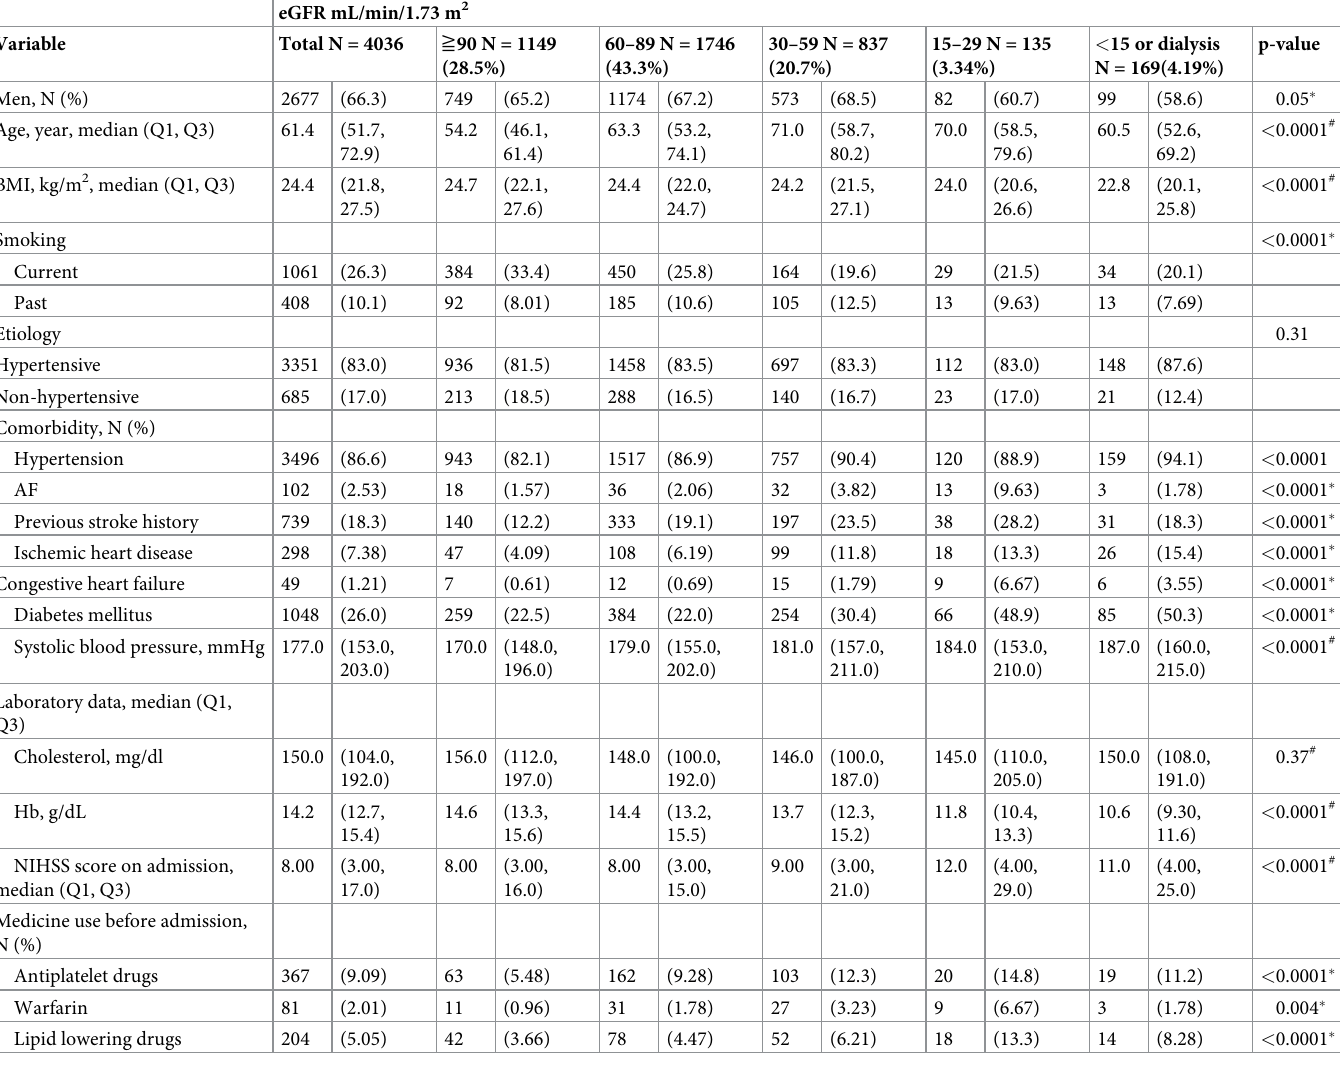
Table 1. Baseline characteristics of patients with intracerebral hemorrhage by eGFR levels on